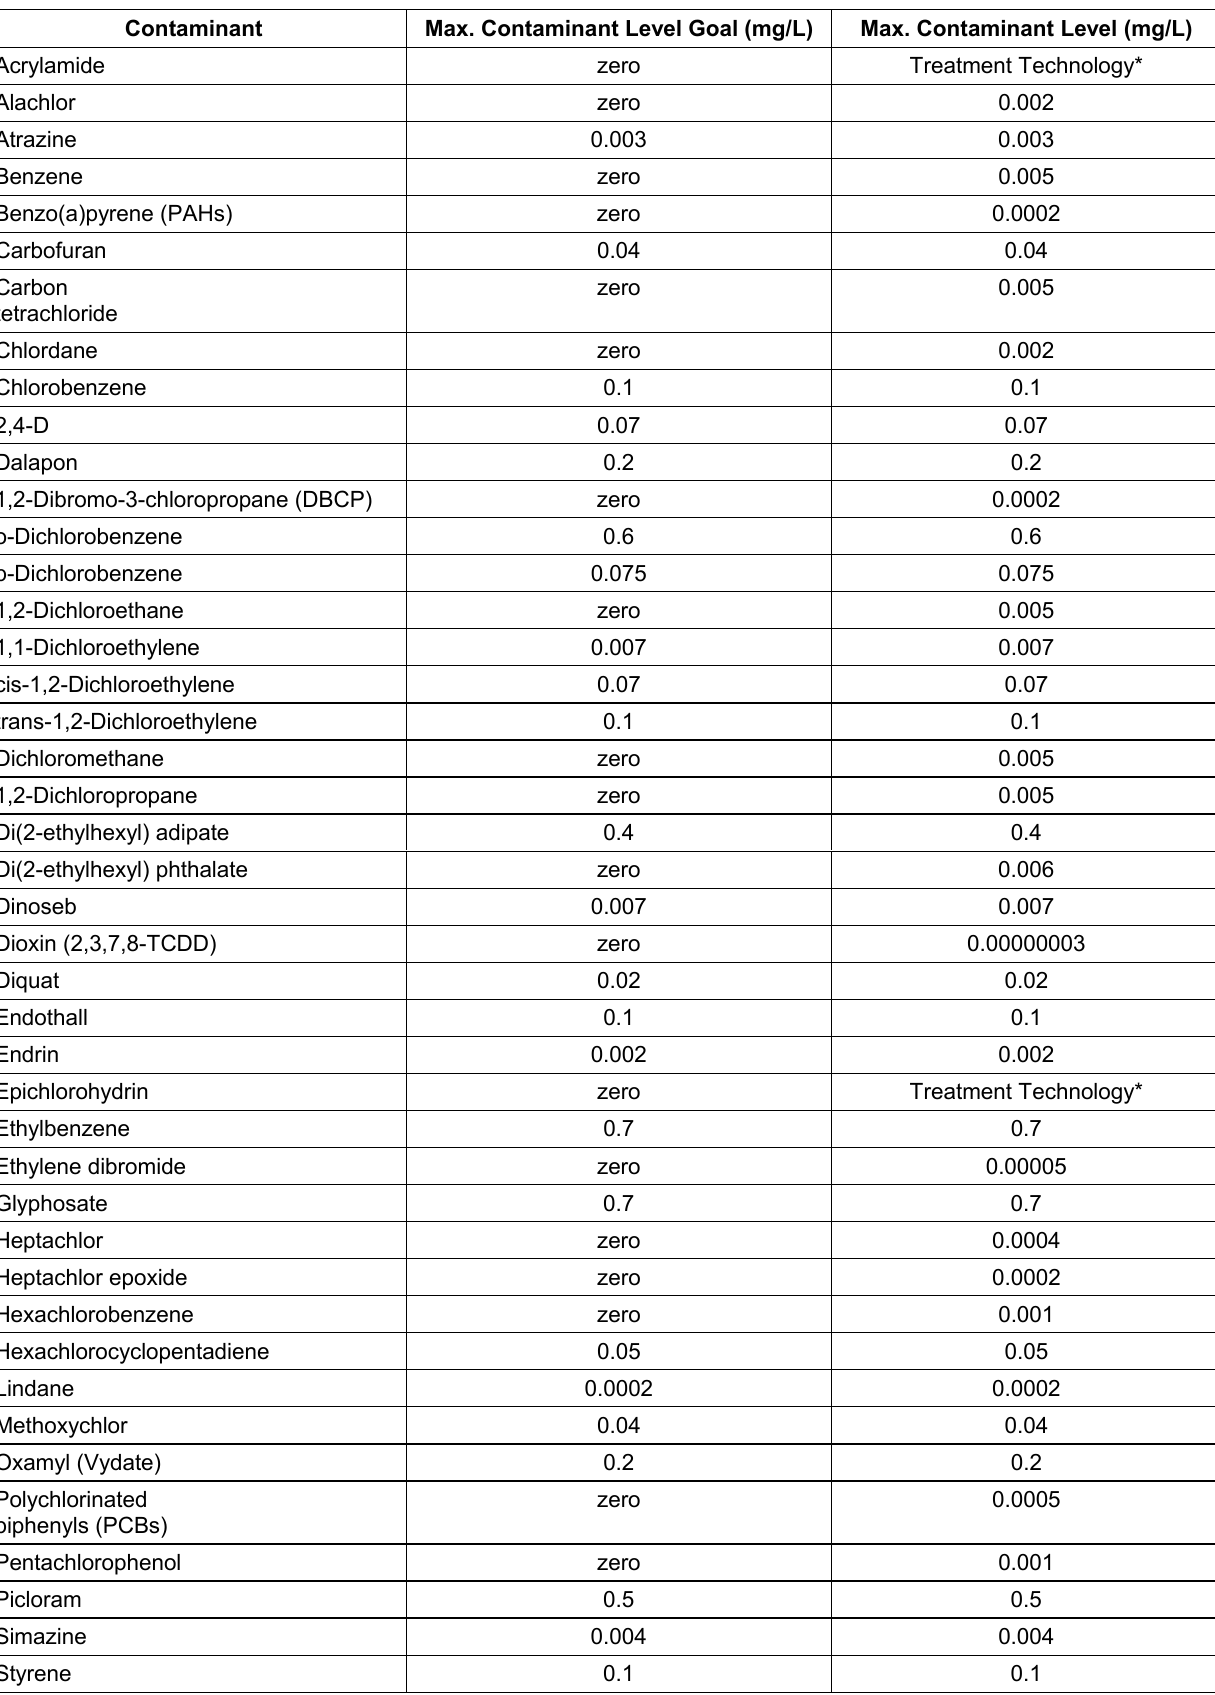
Table 5. EPA national primary drinking water standards for organic